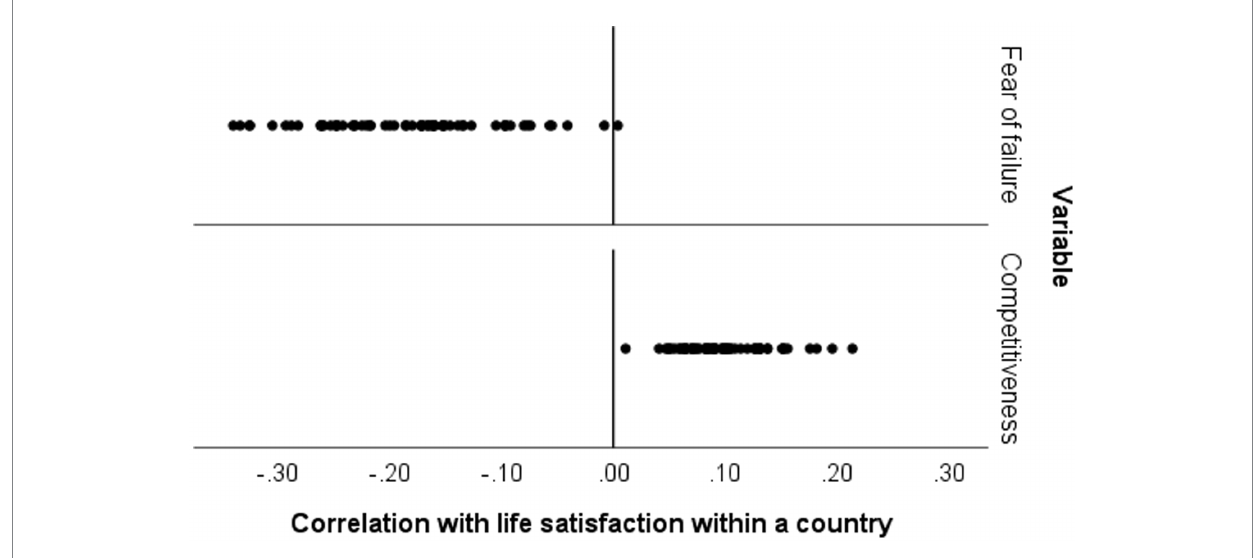
FIGURE 3 Within-country correlations, in 63 countries, between life satisfaction and fear of failure (top) and between life satisfaction and competitiveness (bottom).